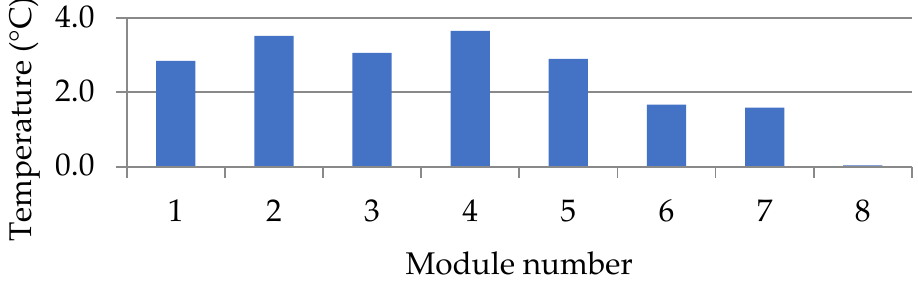
Figure 25. Temperature correction values for equalization of the results due to the influence of different amounts of solar irradiance. The minimum temperature of the module in the short-circuit state, given in Figure 26, shows a growth trend in the daily temperature for September. The increase in the value of module 4 is a result of heating caused by significant dissipation of the hot spot.